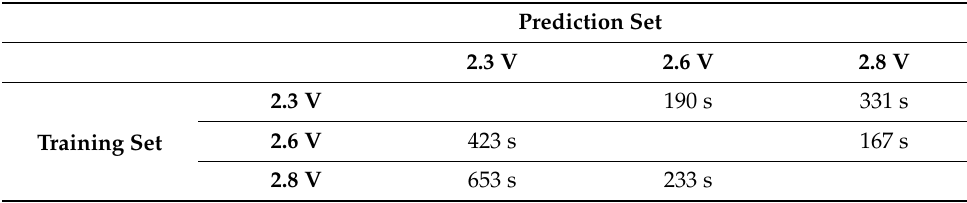
Figure 13. Scatter plot comparing the ANN predictions with experimental data (the actual values for τ ’ ) for test data set of 2.8 V (and training data set of 2.3 V). Table 3. Average absolute error in the final 1800 s (prior to attaining a melt-fraction of 85%) for different training/prediction data-set combinations using transient PCM-temperature